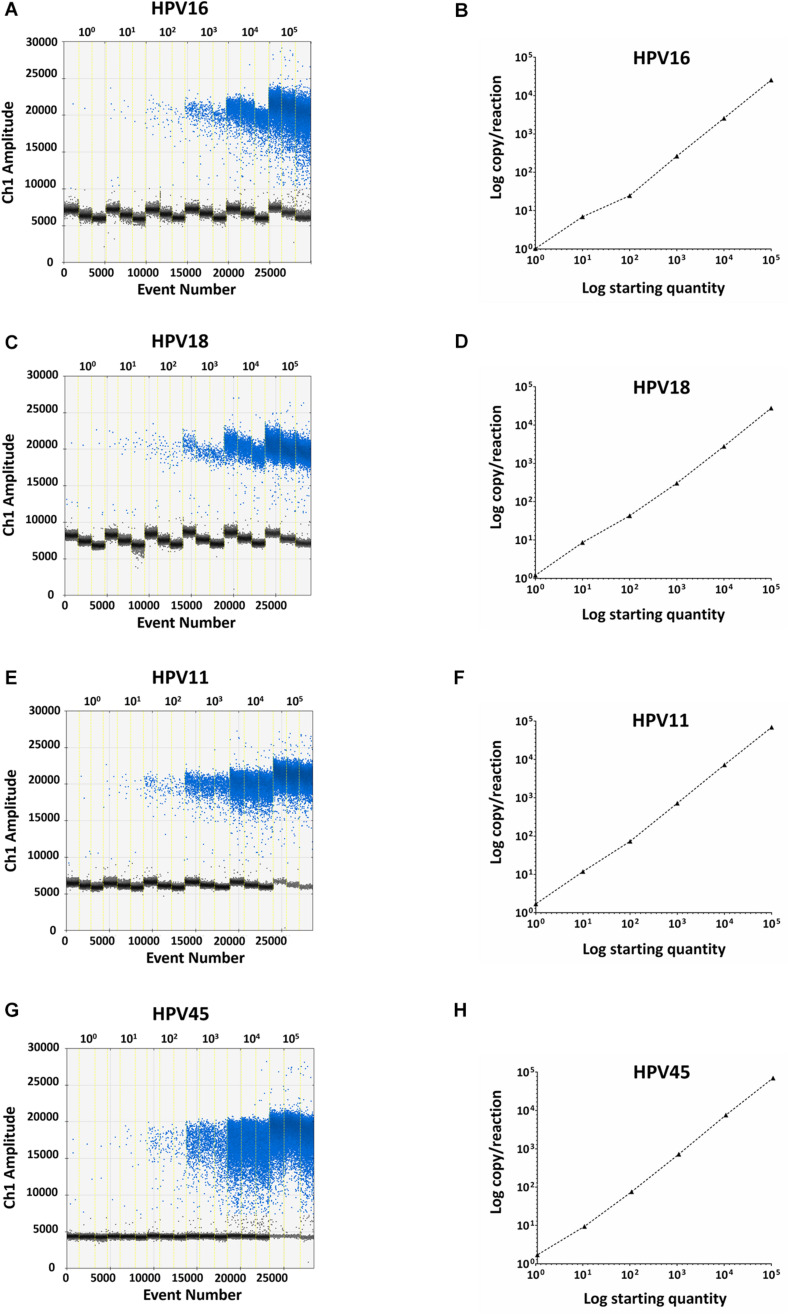
Representative ddPCR amplifications of pUC19/pGEM1 plasmids with HPV16/18/11/45 genomes, together with the correlation between theoretical and detected plasmid concentrations. Ten-fold serial dilutions of pUC19_HPV16 (A), pUC19_HPV18 (C), pUC19_HPV11 (E), pGEM1_HPV45 (G) plasmids ranging from 100 to 105 copies/μL are showed. All panels: vertical lines represent the different plasmid concentrations: 100, 101, 102, 103, 104, 105 copies/μL. The correlation was assessed by plotting the log copy/reaction against the log starting concentration of 10-fold serial dilutions of pUC19_HPV16 (B), pUC19_HPV18 (D), pUC19_HPV11 (H), pGEM1_HPV45 (F) plasmids. The ddPCR gave high accuracy for pUC19_HPV16, pUC19_HPV18, and pUC19_HPV11, with an R2 of 1 and a P = 0.0001, whereas pGEM1_HPV45 was detected with good accuracy, with an R2 of 0.9999 and a p = 0.0001. Linear regression analysis was performed using GraphPad Prism software.